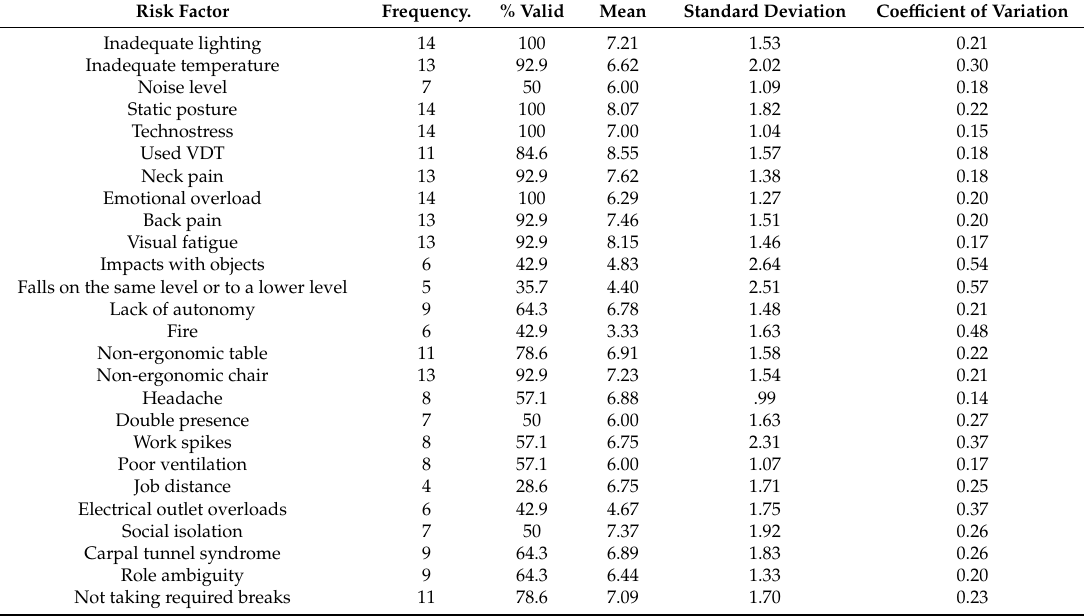
Table 3. Comparison of frequency and percentage of agreement between experts and degree of consensus on each